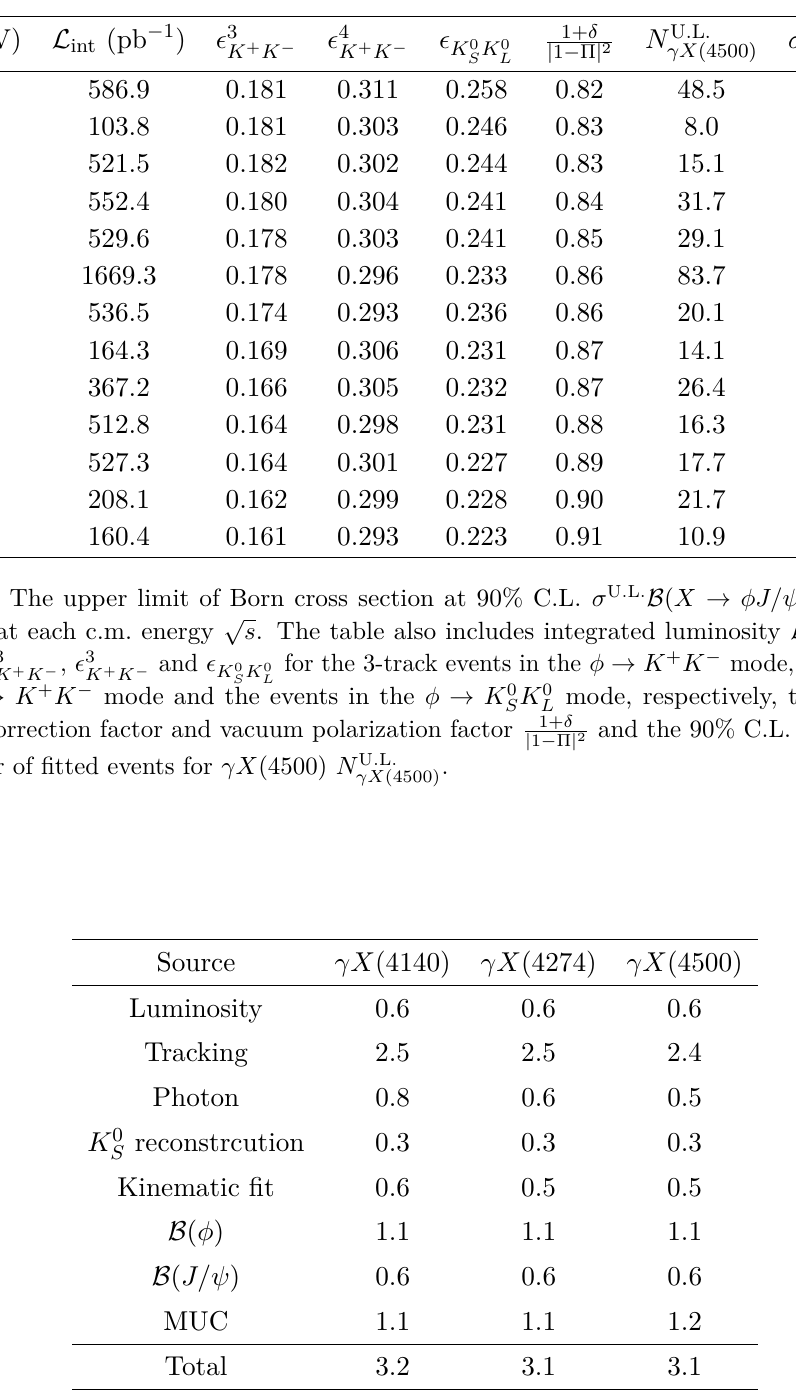
Table 12 . Systematic uncertainty sources and their contributions (in %) for the cross section